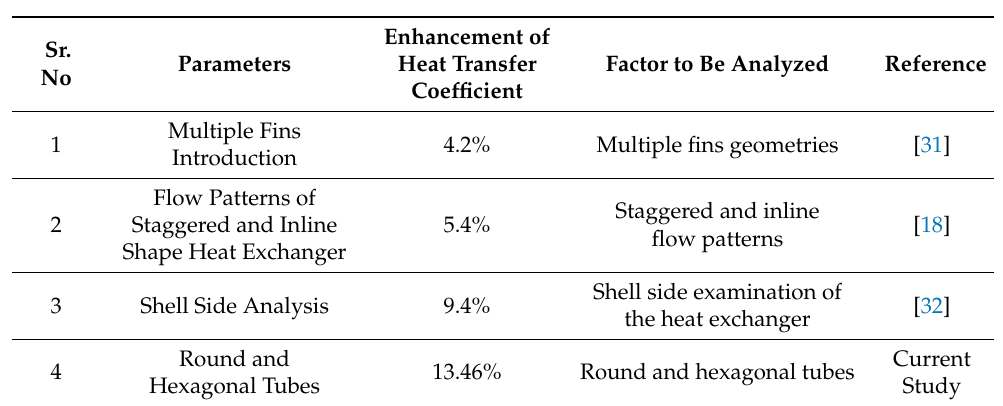
Table 7. Comparison of